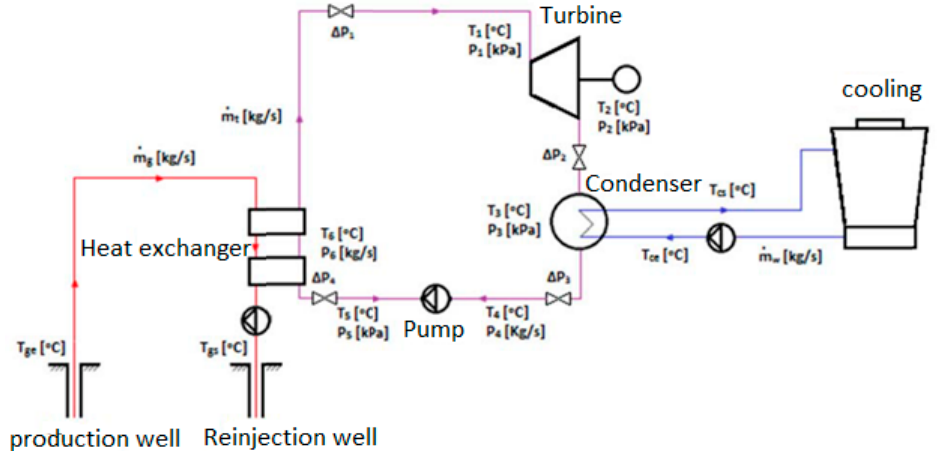
Figure 1. Outline of the ORC binary plant